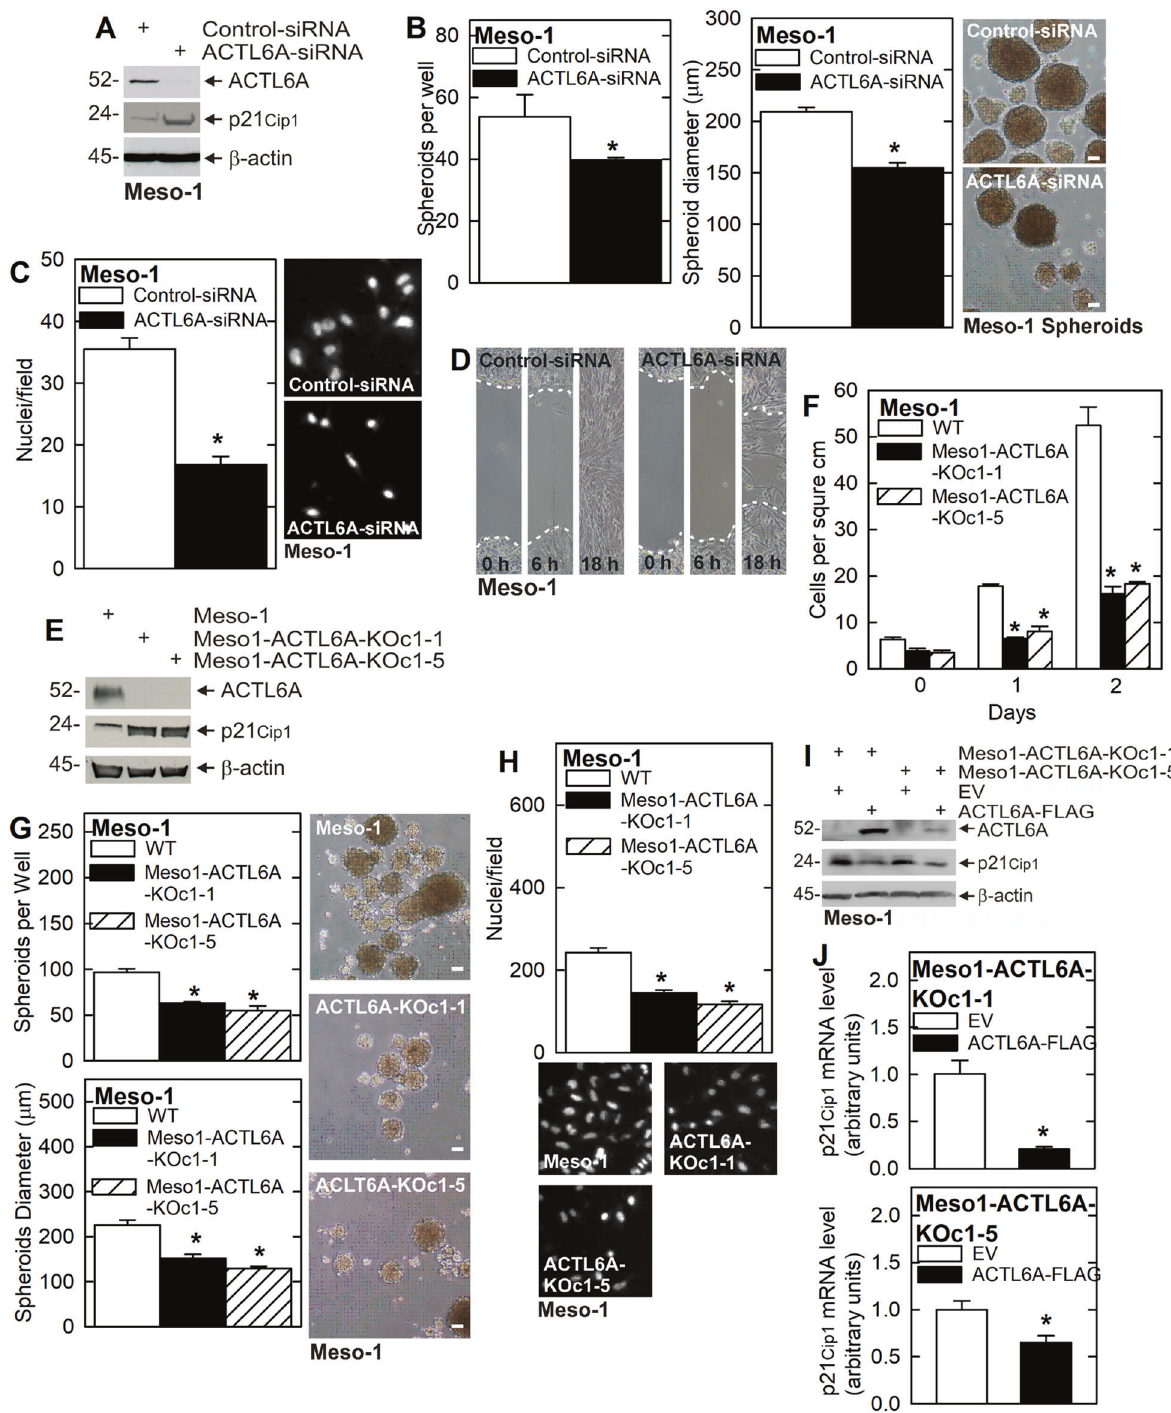
Fig. 1 ACTL6A maintains the aggressive cancer phenotype. A ACTL6A was successfully knocked down using ACTL6A-siRNA which leads to an increase in p21 Cip1 protein level. B – D ACTL6A knockdown decreases spheroid number and size, invasion and migration. For spheroid assay, 40,000 cells were seeded on ultra-low attachment plates and counted at Day 4. Spheroid diameters were measured using ImageJ. E – H ACTL6A knockout cell clones, which lack ACTL6A, display elevated p21 Cip1 expression and this is associated with reduced cell proliferation, spheroid formation and invasion. I , J ACTL6A overexpression in ACTL6A knockout cell clones reduces p21 Cip1 protein and mRNA levels. Asterisks indicate a signi fi cant decrease ( n = 3, p ≤ this is associated with reduced cell proliferation, spheroid number spheroid size and number, invasion and migration (Fig. 1B – D). To and diameter, and cell invasion (Fig. 1F – H). We next performed further characterize the role of ACTL6A, we characterized ACTL6A the inverse experiment and restored ACTL6A expression in knockout cells. The ACTL6A-KOc1-1 and ACTL6A-KOc1-5 clonal cell ACTL6A knockout cells. We show that restoring ACTL6A level is lines display a marked increase in p21 Cip1 expression (Fig. 1E) and